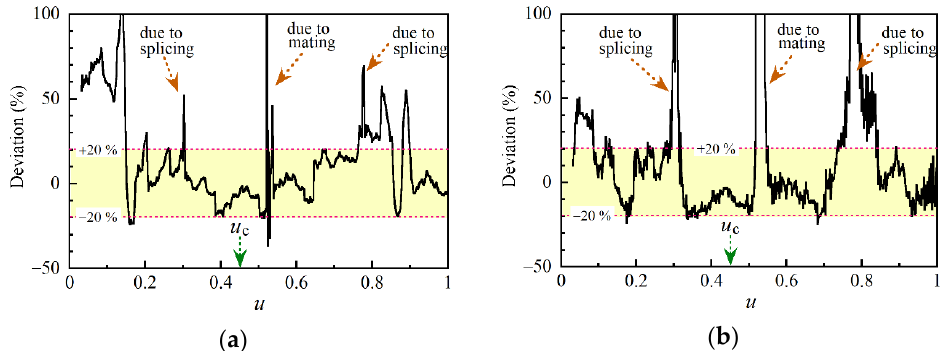
Figure 8. Difference between the calculated and measured S/N values in percent as a function of u . ( a , b ) were obtained from the data shown in Figures 6b and 7b, respectively, where the center of pumping was located at u c = 0.45. The range where the deviation was within 20% was highlighted in yellow in each figure. The rapid changes observed around u = 0.31, 0.53 and 0.78 were caused by fusion splicing and mating of the pieces of the single-mode fiber.